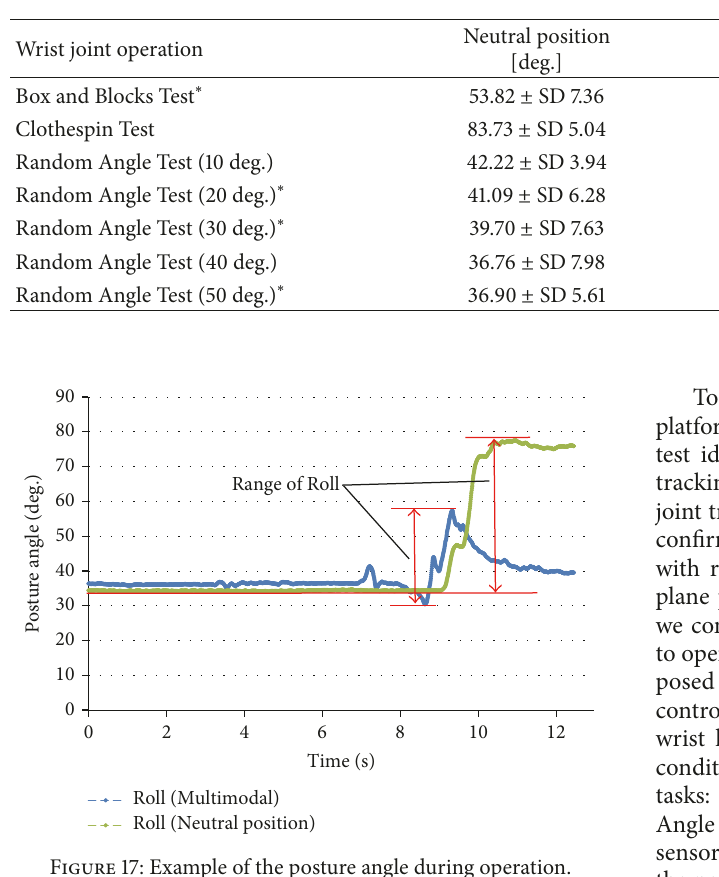
Figure 17: Example of the posture angle during